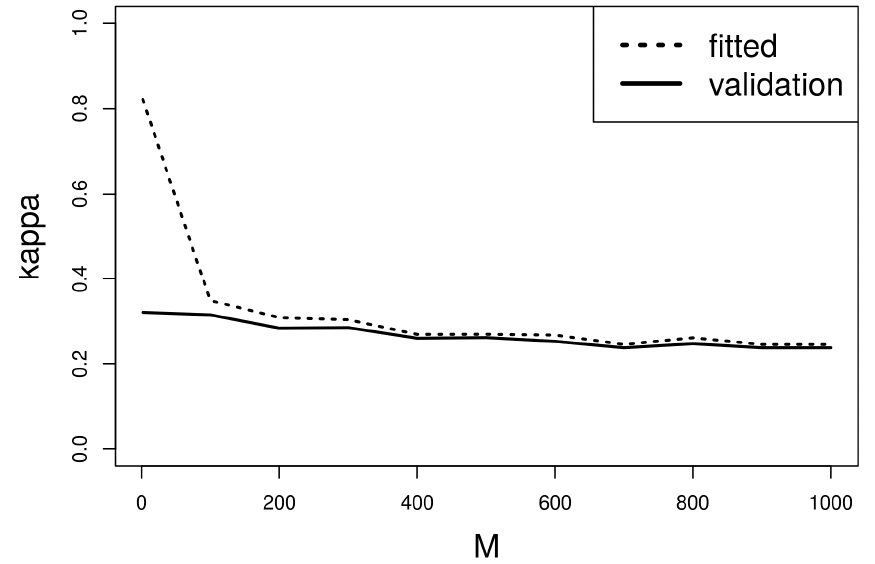
Figure 1. Accuracy of fitted and validation (Cohen’s Kappa) depending on M parameter using 50% of observations as validation sample.